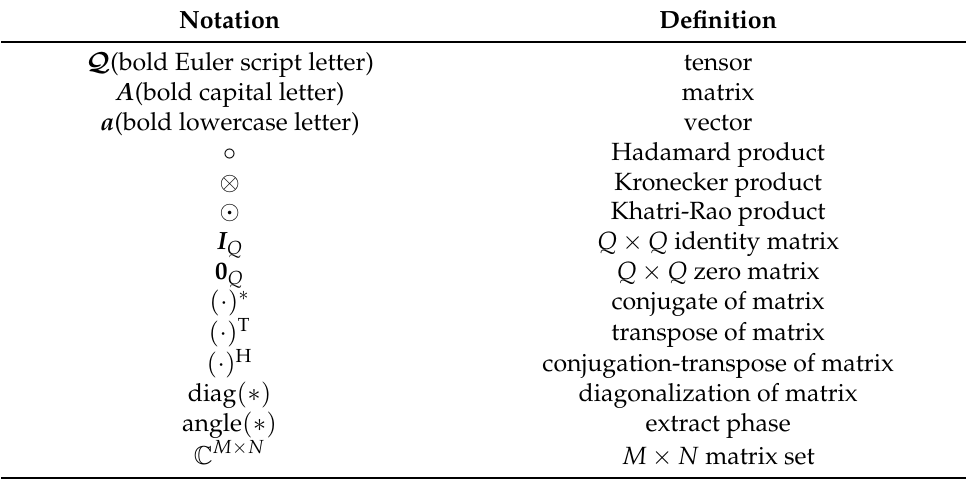
Table 1. Related